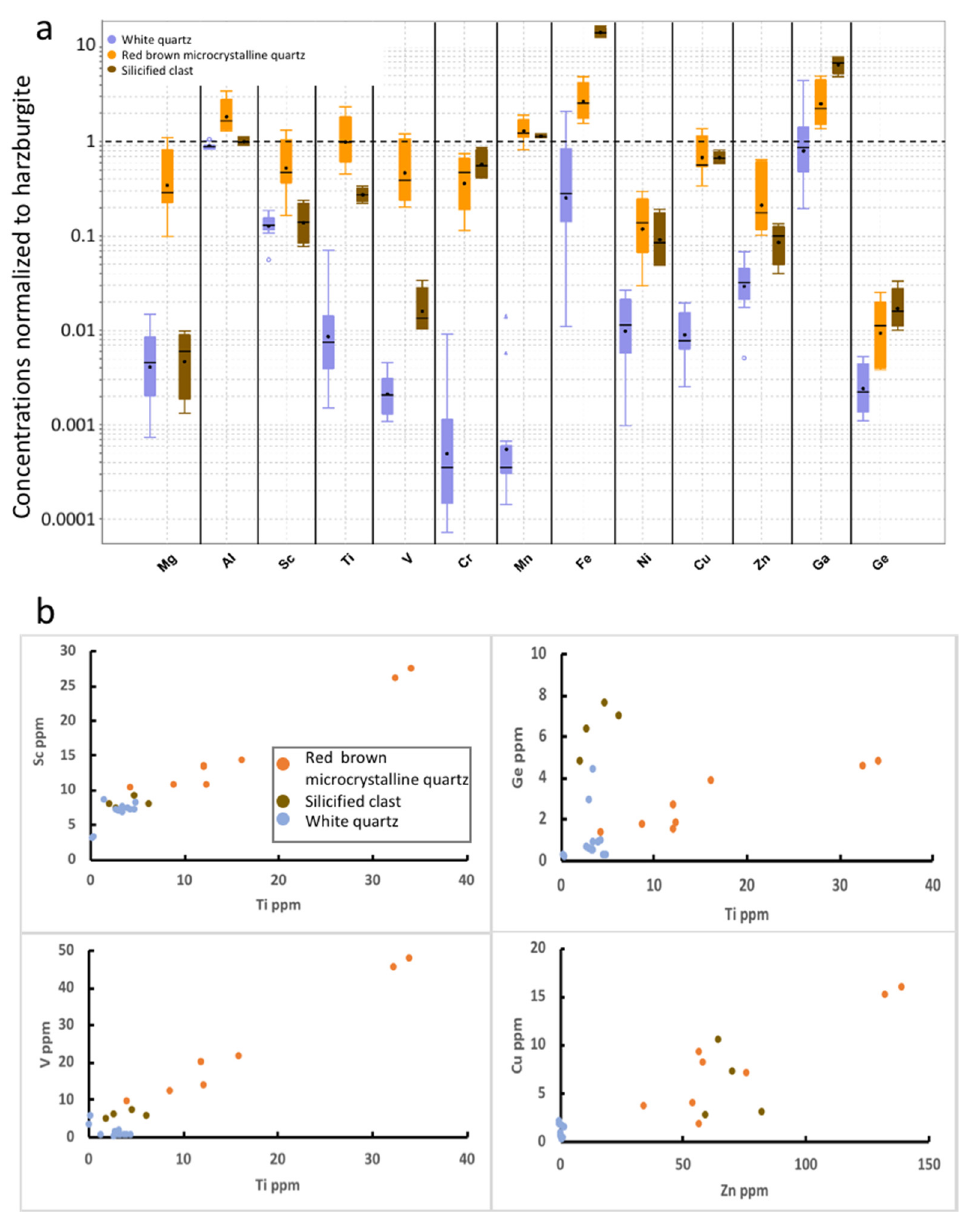
Figure 8. Trace elements in red-brown microcrystalline quar tz , silici fi ed clast and white quar tz cement. ( a ) Normalised concentrations to harzburgite concentrations. ( b ) Binary plots, Sc-Ti, Ge-Ti, V-Ti and Cu-Zn for the three types of quar tz .